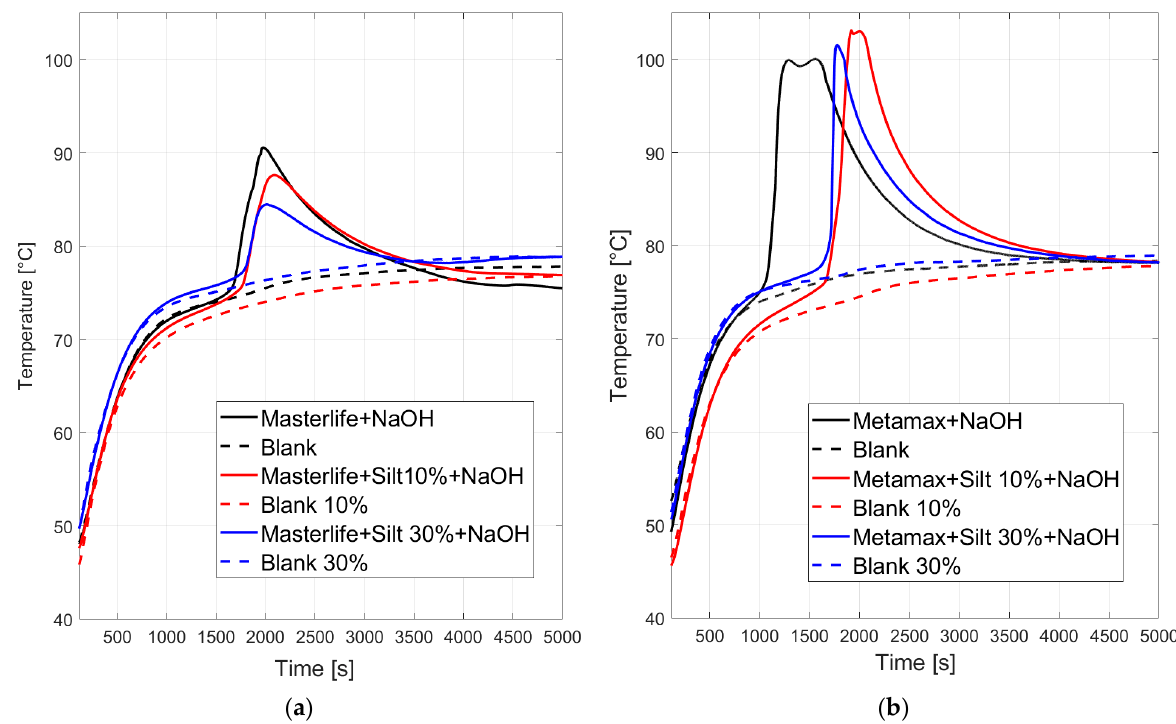
Figure 2. Thermal profiles of the geopolymer reactions: ( a ) samples made with metakaolin Masterlife MK828; ( b ) samples made with metakaolin Metamax. Black, red, and blue curves show the thermal profiles of samples 1 and 4, samples 2 and 5, samples 3 and 6, respectively.